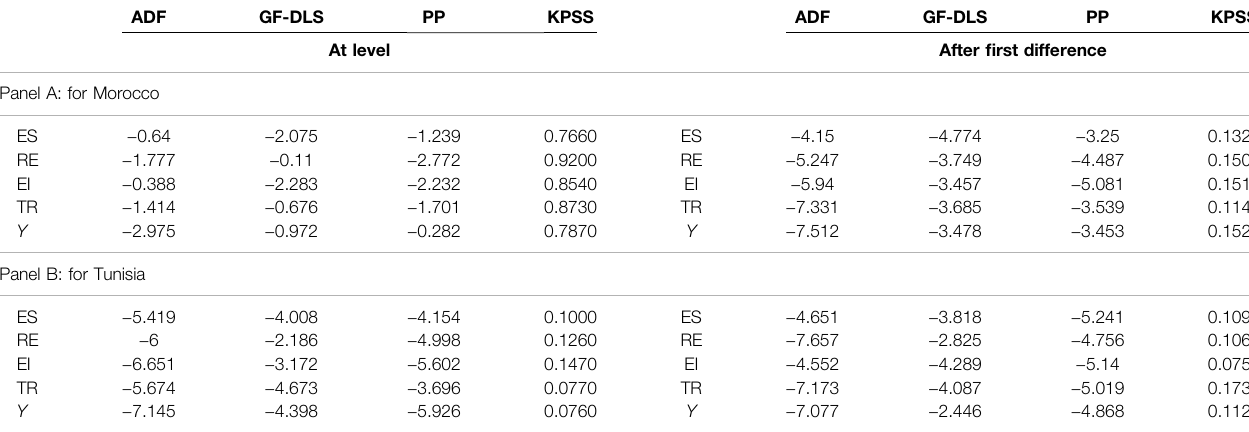
TABLE 4 | Results of conventional unit root